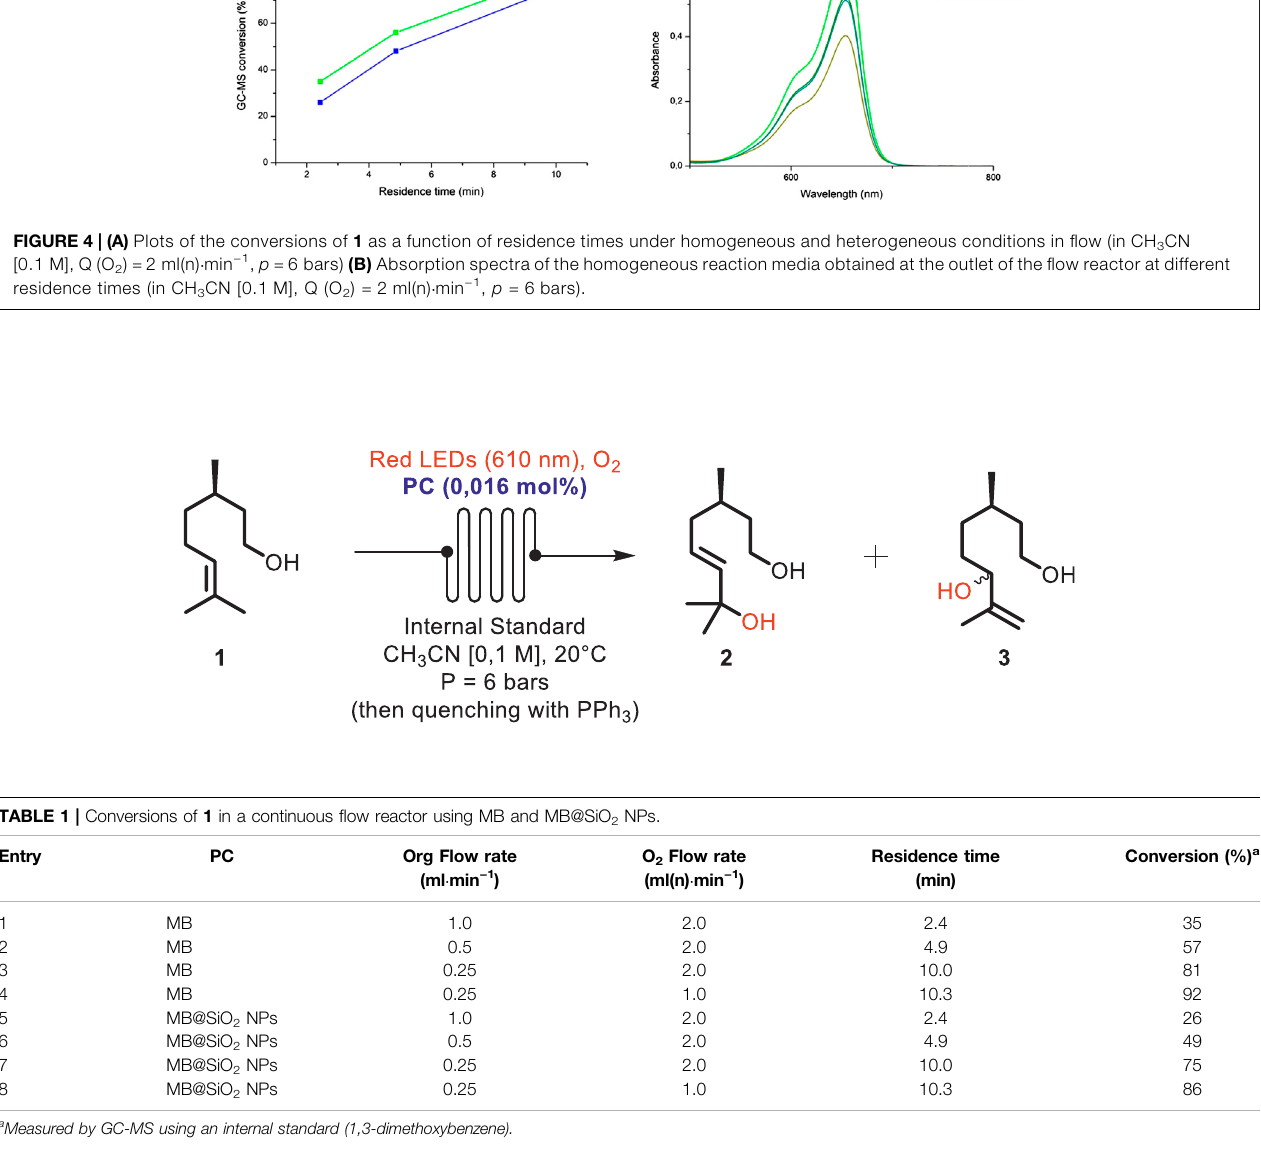
(Entry 8). This corresponds to a STY of 82 g h − 1 L − 1 which is studies with the heterogeneous PCs.